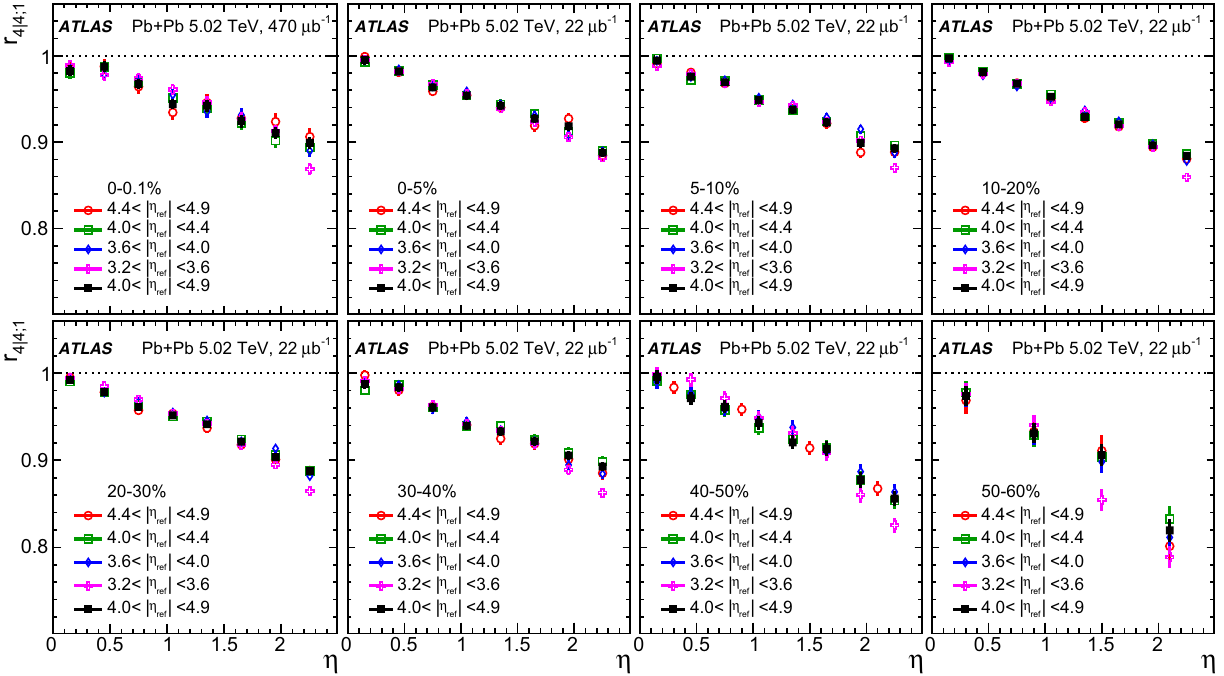
Fig. 27 The r 4 | 4 ; 1 (η) measured for several η ref ranges for Pb+Pb collisions at 5.02 TeV. Each panel represents one centrality range. The error bars are statistical only. The data points in some centrality intervals are rebinned to reduce the